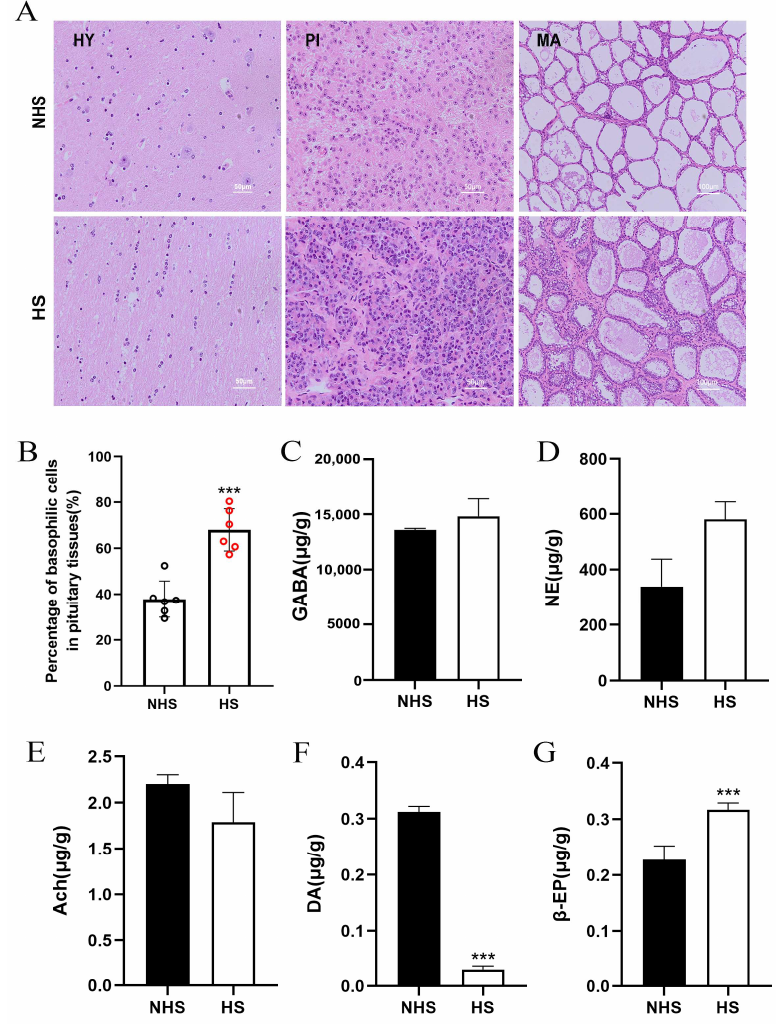
Figure 2. Histomorphological observation of HPM-axis related tissues and neurotransmitters in hypothalamus between the NHS and HS groups. ( A ) Histomorphological observation of HPM-axis related tissues. HY: hypothalamus; PI: pituitary; MA: mammary gland. ( B ) The percentage of basophils in pituitary. ( C – G ) Neurotransmitters in hypothalamus. Data are presented as the mean ± SEM ( n = 6 per group); *** p < 0.001.